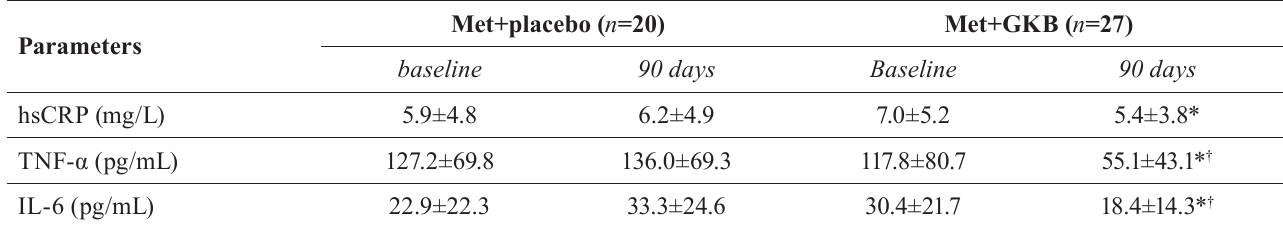
TABLE III - Changes in the inflammatory markers of T2DM patients maintained on metformin and treated with Ginkgo biloba extract Met+placebo ( n =20) Met+GKB ( n =27) Parameters baseline 90 days Baseline hsCRP (mg/L) TNF-α (pg/mL)